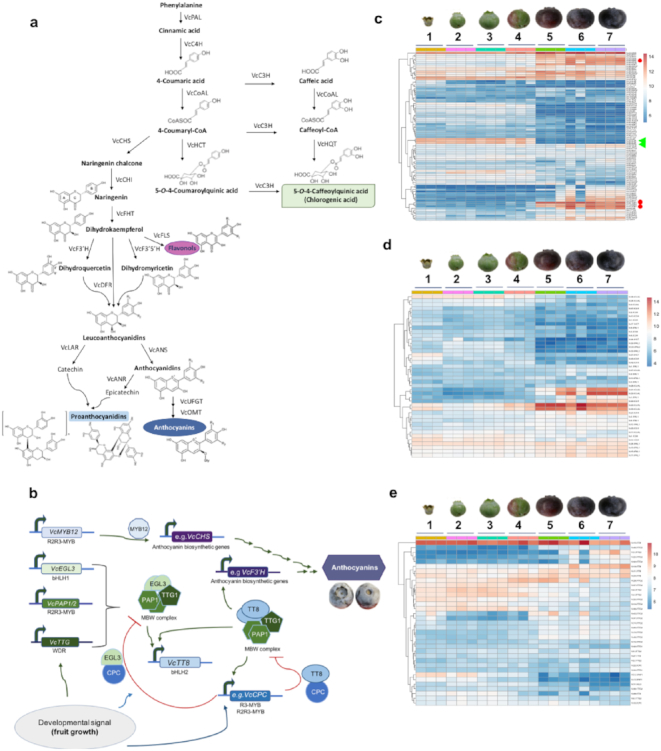
A schematic presentation of flavonoid biosynthesis in blueberry. (a) Predicted flavonoid biosynthetic pathway leading to production of anthocyanin. The proposed pathway is based on previously described flavonoid biosynthetic pathway in plants (Zifkin et al. [68]) and expression of predicted anthocyanin biosynthetic genes in blueberry. The core genes include phenylalanine ammonia-lyase (PAL), 4-hydroxycinnamoyl CoA ligase (4CL), trans-cinnamate 4-monooxygenase (C4H), cytochrome P450 98A3 (C3H), chalcone synthase (CHS), chalcone flavonone isomerase (CHI), flavanone-3β-hydroxylase (FHT), flavanone 3-hydroxylase (F3H), flavonoid 3′-hydroxylase (F3′H), flavonoid 3′,5′-hydroxylase (F3′5′H), dihydroflavonol reductase (DFR), leucoanthocyanidin reductase (LAR), anthocyanidin reductase (ANR), anthocyanidin synthase (ANS), UDP-glucose flavonoid 3-O-glucosyl transferase (UFGT), anthocyanin-O-methyltransferase (OMT), hydroxycinnamoyl-CoA shikimate/quinate hydroxycinnamoyltransferase (HCT), and hydroxycinnamoyl-CoA quinate hydroxycinnamoyltransferase (HQT). (b) Hypothetical regulatory pathway of anthocyanin biosynthetic genes based on the proposed model by Albert et al. [92]. (c) Developmental-specific expression pattern of key anthocyanin biosynthetic gene (green triangles = examples of genes upregulated during early fruit growth; red circles = examples of genes upregulated during late fruit development). (d) Chlorogenic acid biosynthetic genes (1 = petal fall, 2 = small green fruit, 3 = expanding green fruit, 4 = pink fruit, 5 = fruit color completely changed from pink to purple, 6 = unripe, 7 = ripe). (e) Expression profile of transcription factors predicted to regulate anthocyanin biosynthesis in blueberry. A high-resolution version of the heat maps is available on PURR (see Availability of Supporting Data section).